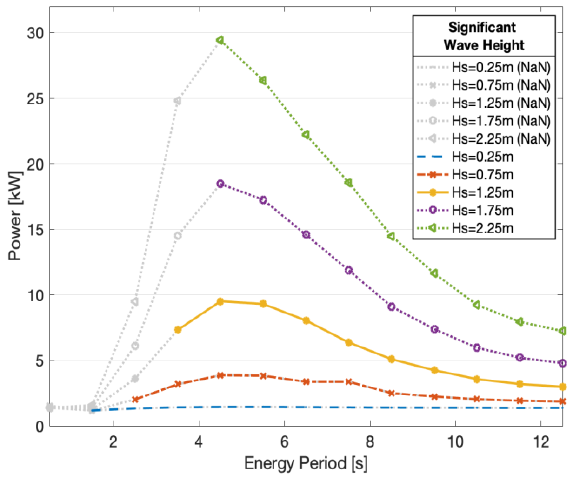
Figure 8. Generated power production from WEC varied with energy period (five cases of significant wave heights were chosen). Curves with data in grey are physically non-existent in ocean waves.